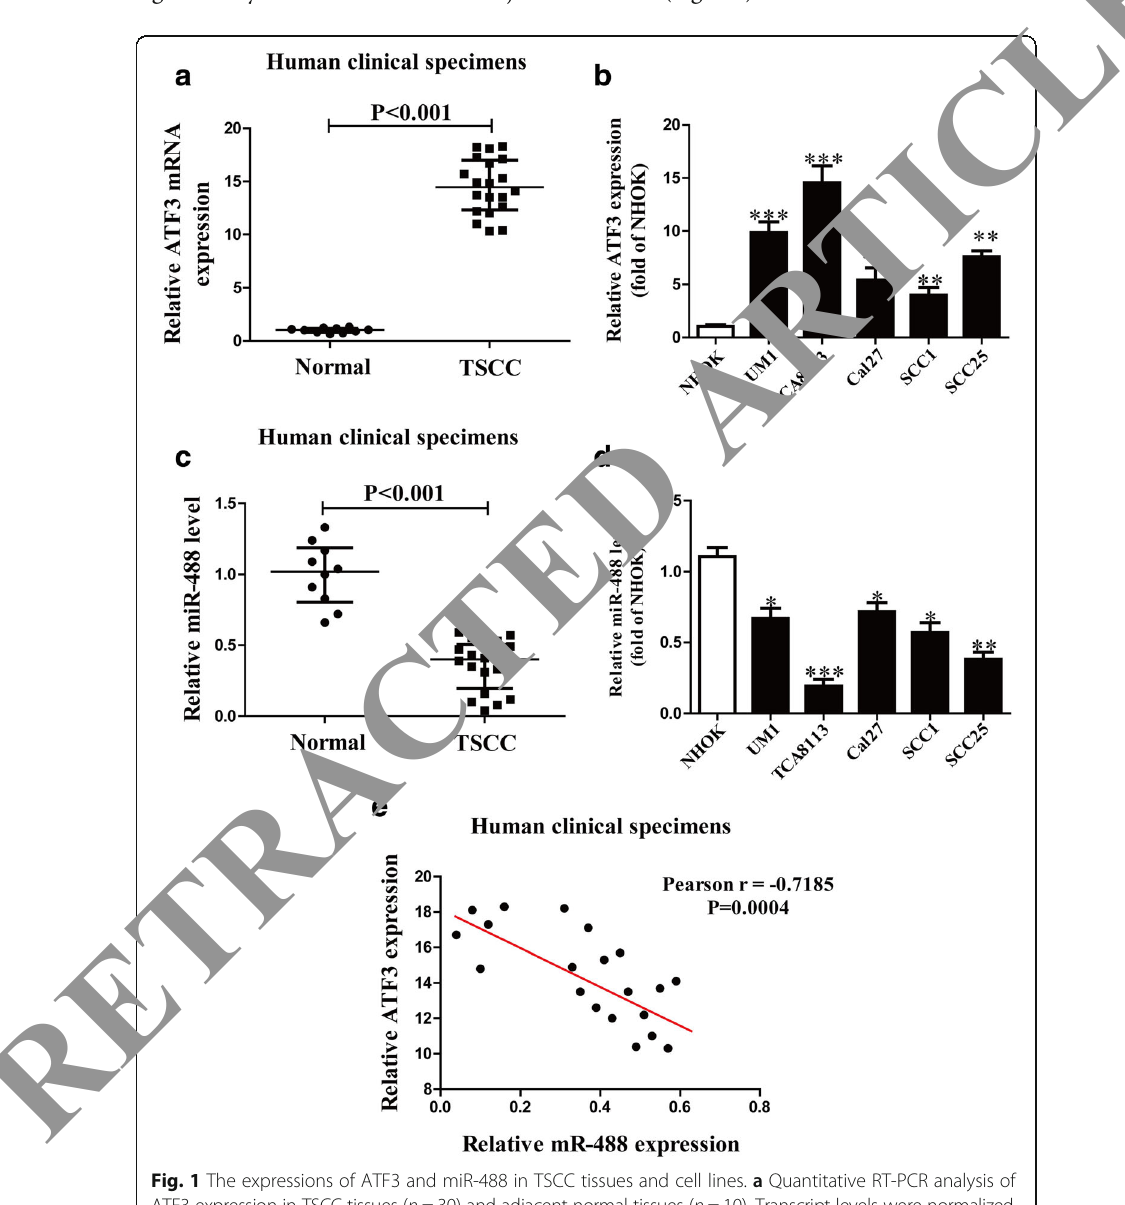
Fig. 1 The expressions of ATF3 and miR-488 in TSCC tissues and cell lines. a Quantitative RT-PCR analysis of ATF3 expression in TSCC tissues ( n =30) and adjacent normal tissues ( n =10). Transcript levels were normalized to GAPDH expression. b Relative ATF3 expression analyzed via quantitative RT-PCR in five TSCC cell lines normalized to GAPDH ( n =6). c Quantitative RT-PCR analysis of miR-488 level in TSCC tissues and adjacent normal tissues. Transcript levels were normalized to U6 level. d Relative miR-488 level analyzed via quantitative RT-PCR in five TSCC cell lines normalized to U6 (n=6). e Pearson ’ s correlation analysis of the relative expression levels of miR-488 and the relative ATF3 mRNA levels in TSCC tissues. All data are presented as means ± SEM. * p <0.05, ** p <0.01, *** p <0.001 vs. normal tissues or